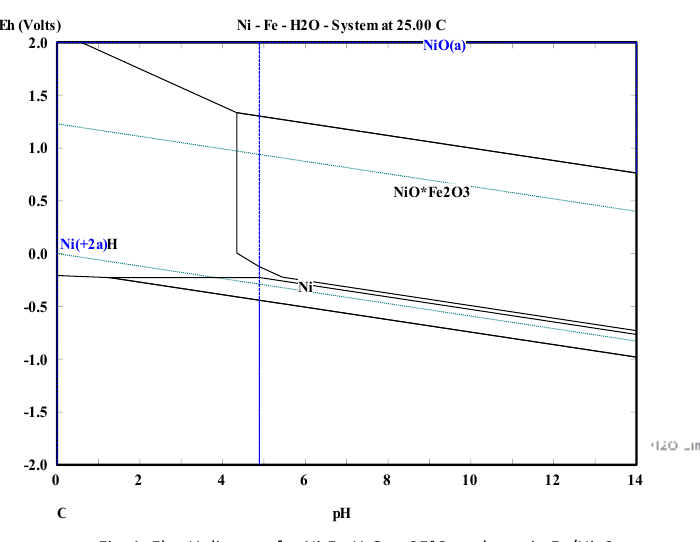
Fig. 1: Eh-pH diagram for Ni-Fe-H 2 O at 25°C, molar ratio Fe/Ni=2